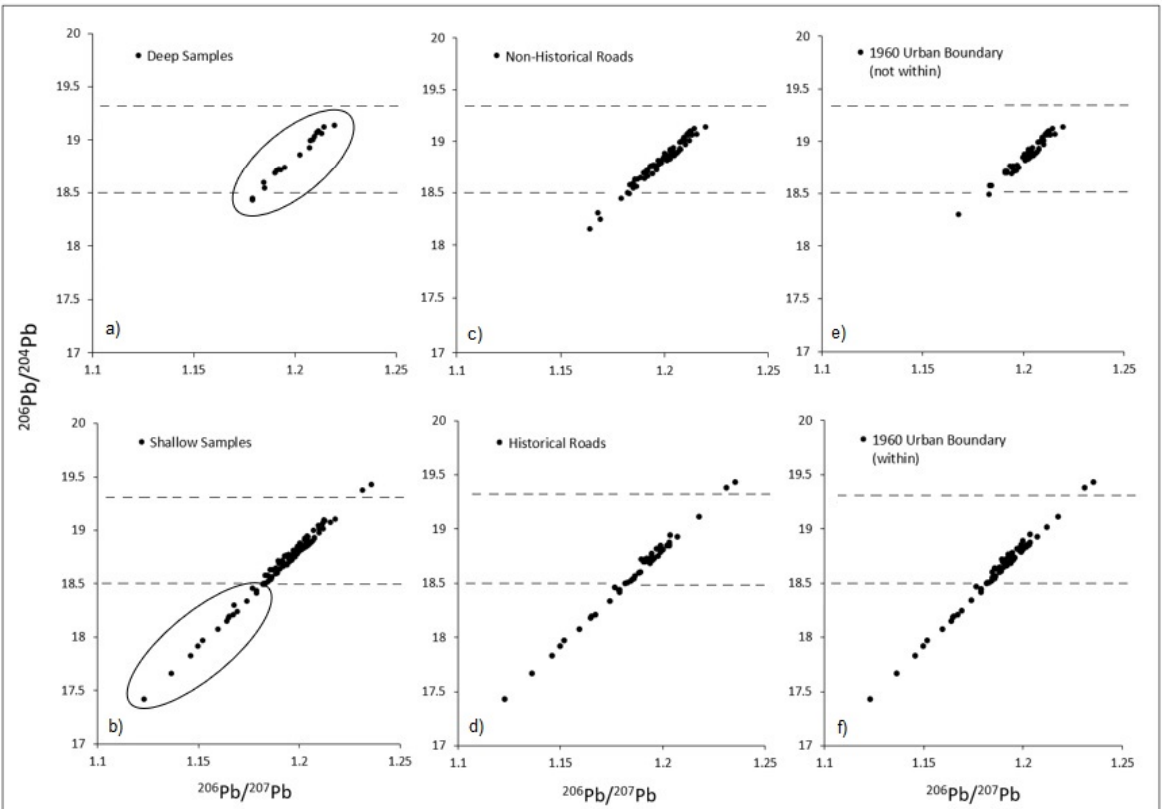
Figure 6. Ratios of 206 Pb/ 204 Pb plotted against 206 Pb/ 207 for ( a ) deep and ( b ) shallow soil samples, as well as soil samples collected near ( c ) non-historical and ( d ) historical roads, and ( e ) outside and ( f ) within the 1960 urban boundary. Dotted lines represent the approximate lower and upper bounds seen across deep sample clusters (top graphs) to enable visual comparison with shallow samples (lower graphs).